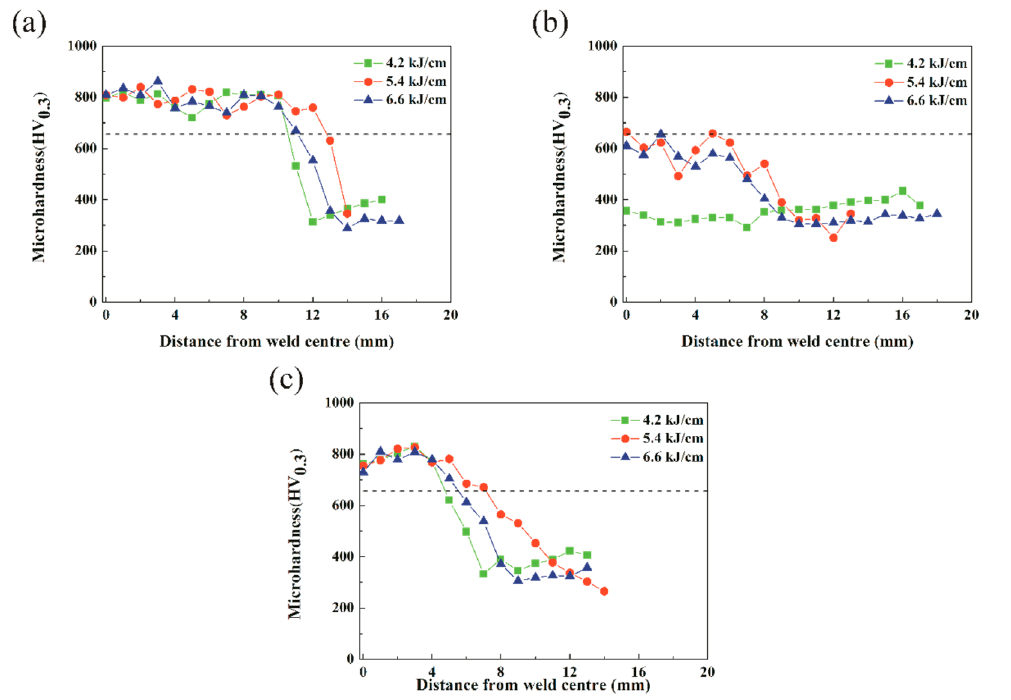
Figure 5. Microhardness distribution on the cross section of samples weld: ( a ) face transverse; ( b ) root transverse; and ( c ) vertical.